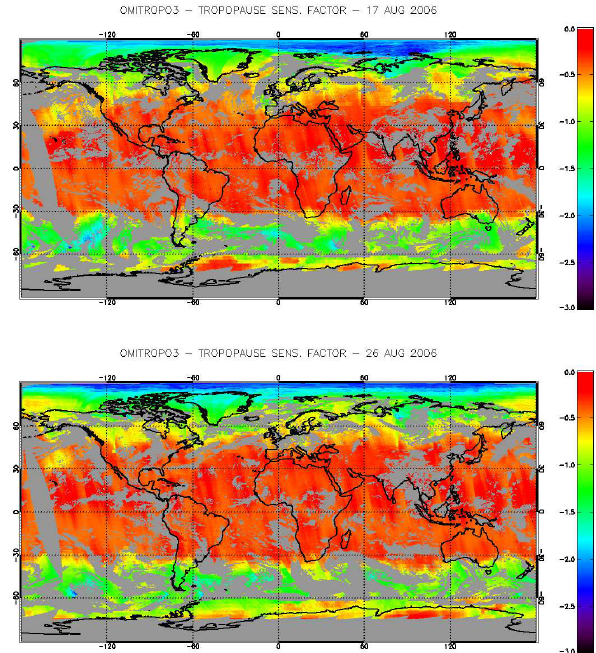
Fig. 16. Global fields of the tropopause sensitivity factor computed for the OMITROPO3-NN algorithm on 17 (top) and 26 August (bot- tom)